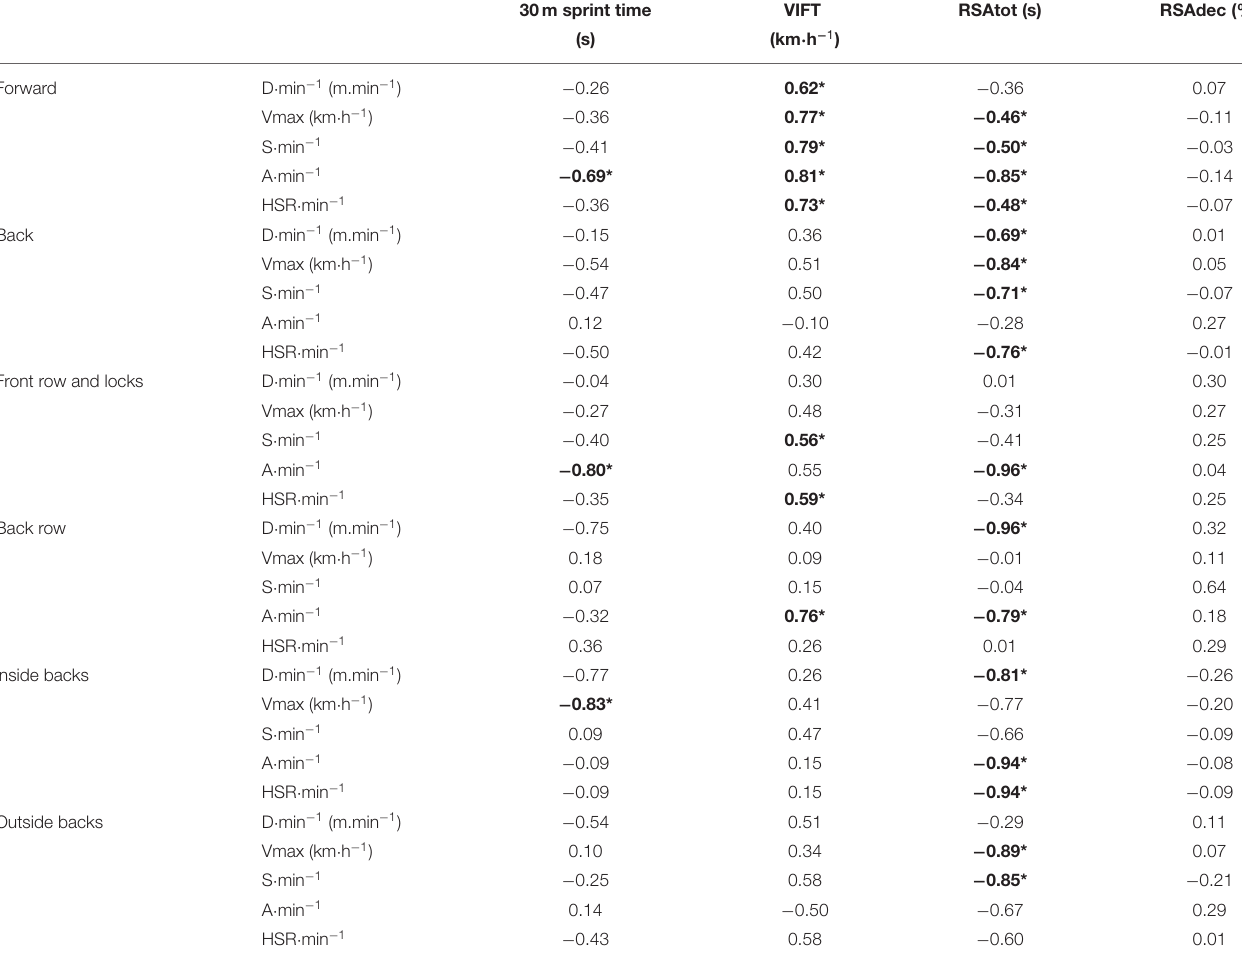
TABLE 1 | Relationships between physical abilities and movement characteristics in matches according to